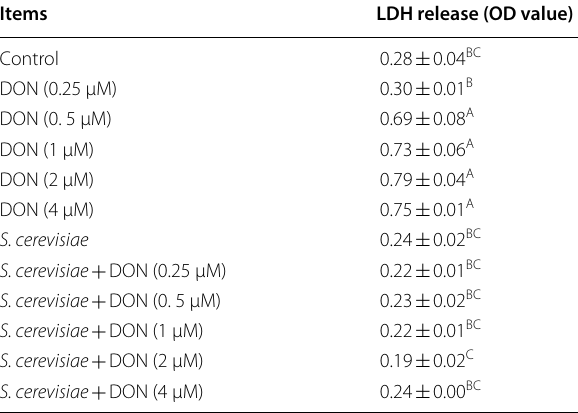
The different capital letters in the column indicated the significant differences ( p < 0.05), while the same capital letters in the column indicated the insignificant differences ( p > 0.05)